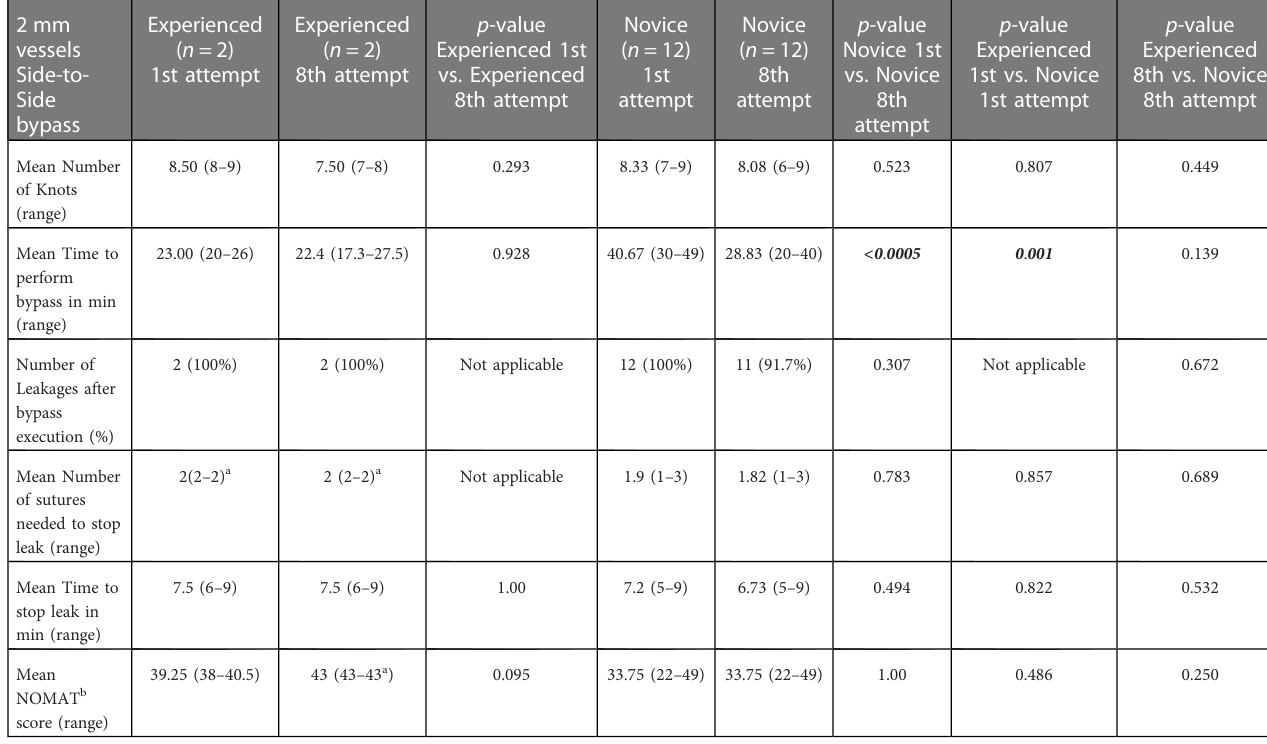
TABLE 3 Results of the NOMAT score and objective task evaluation of the 2 mm vessels Side-to-Side bypass in each group at 1st and 8th